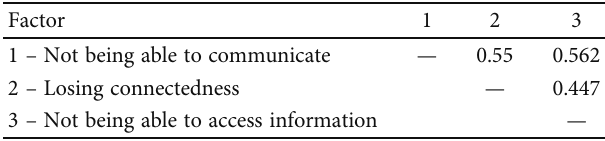
Table 9: Correlations between